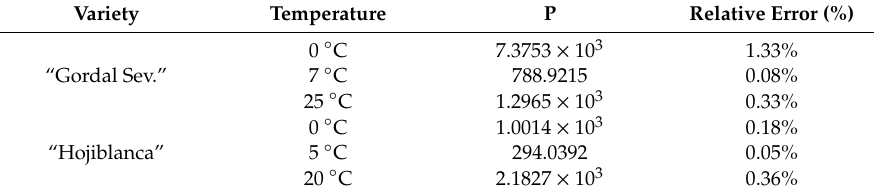
Table 2. Goodness of fit for unripe olives according to variety and temperature.